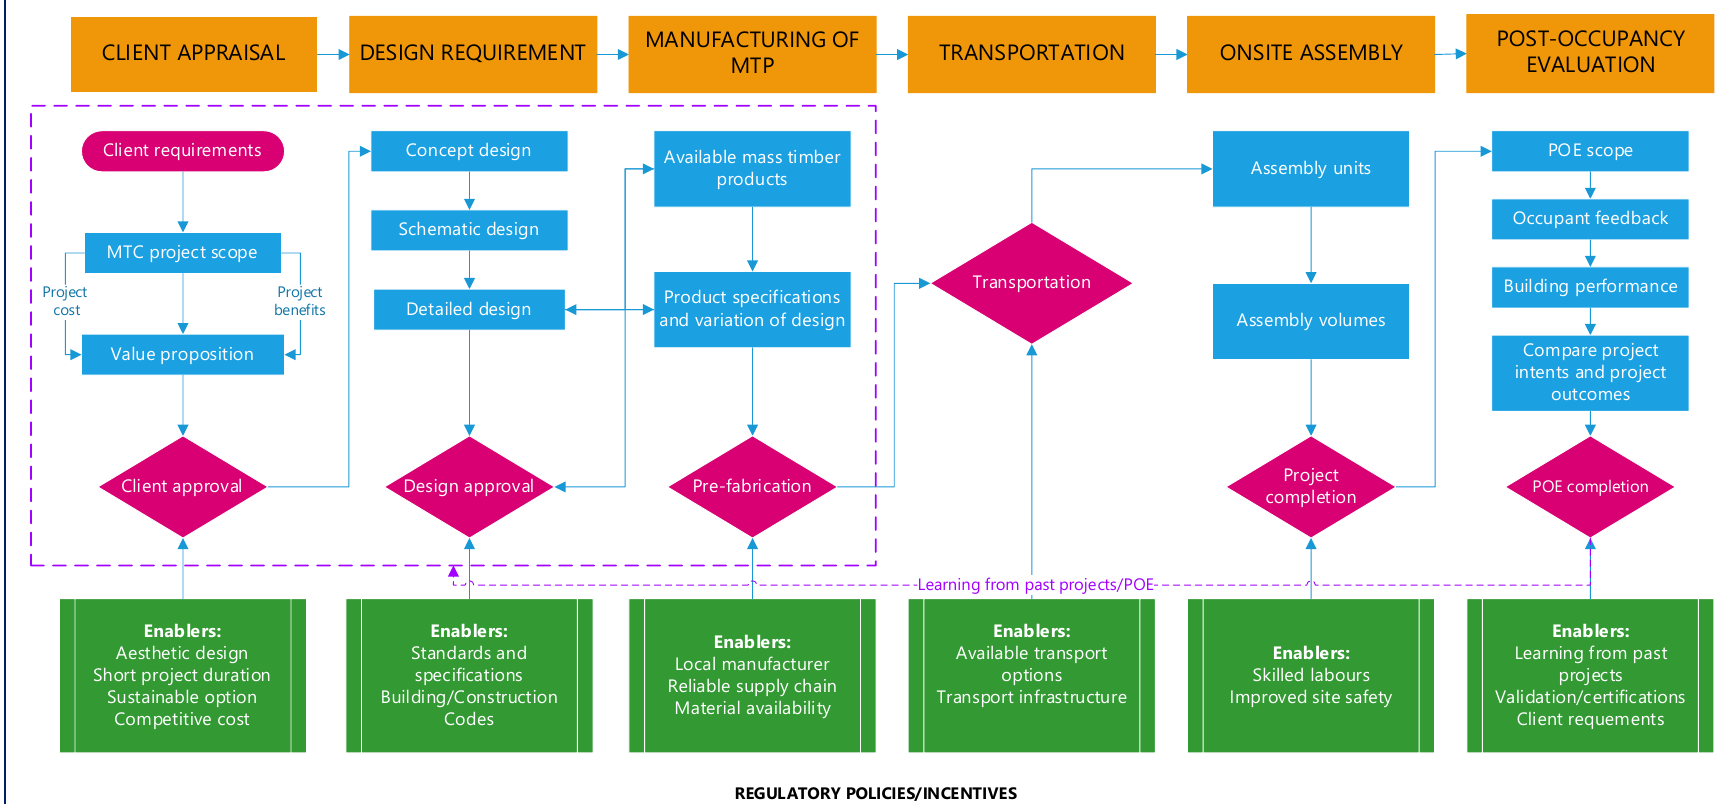
Figure 9. The critical enablers for widespread application of MTC in Australia.